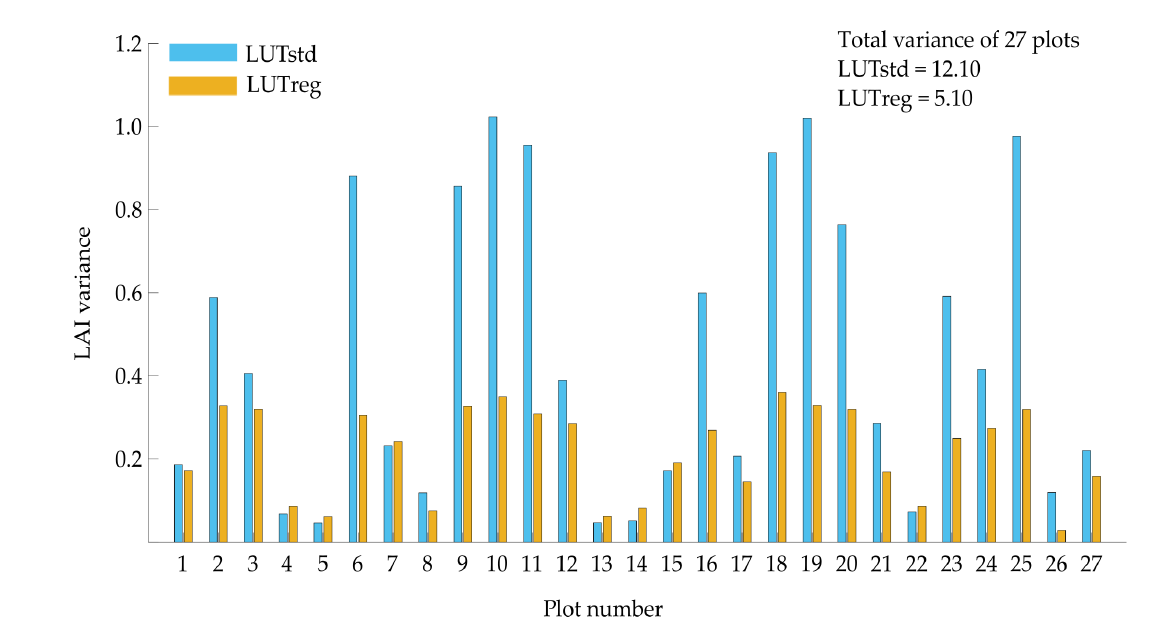
Figure 7. The magnitude of LAI variation across 27 potato plots obtained from both types of LUTs.